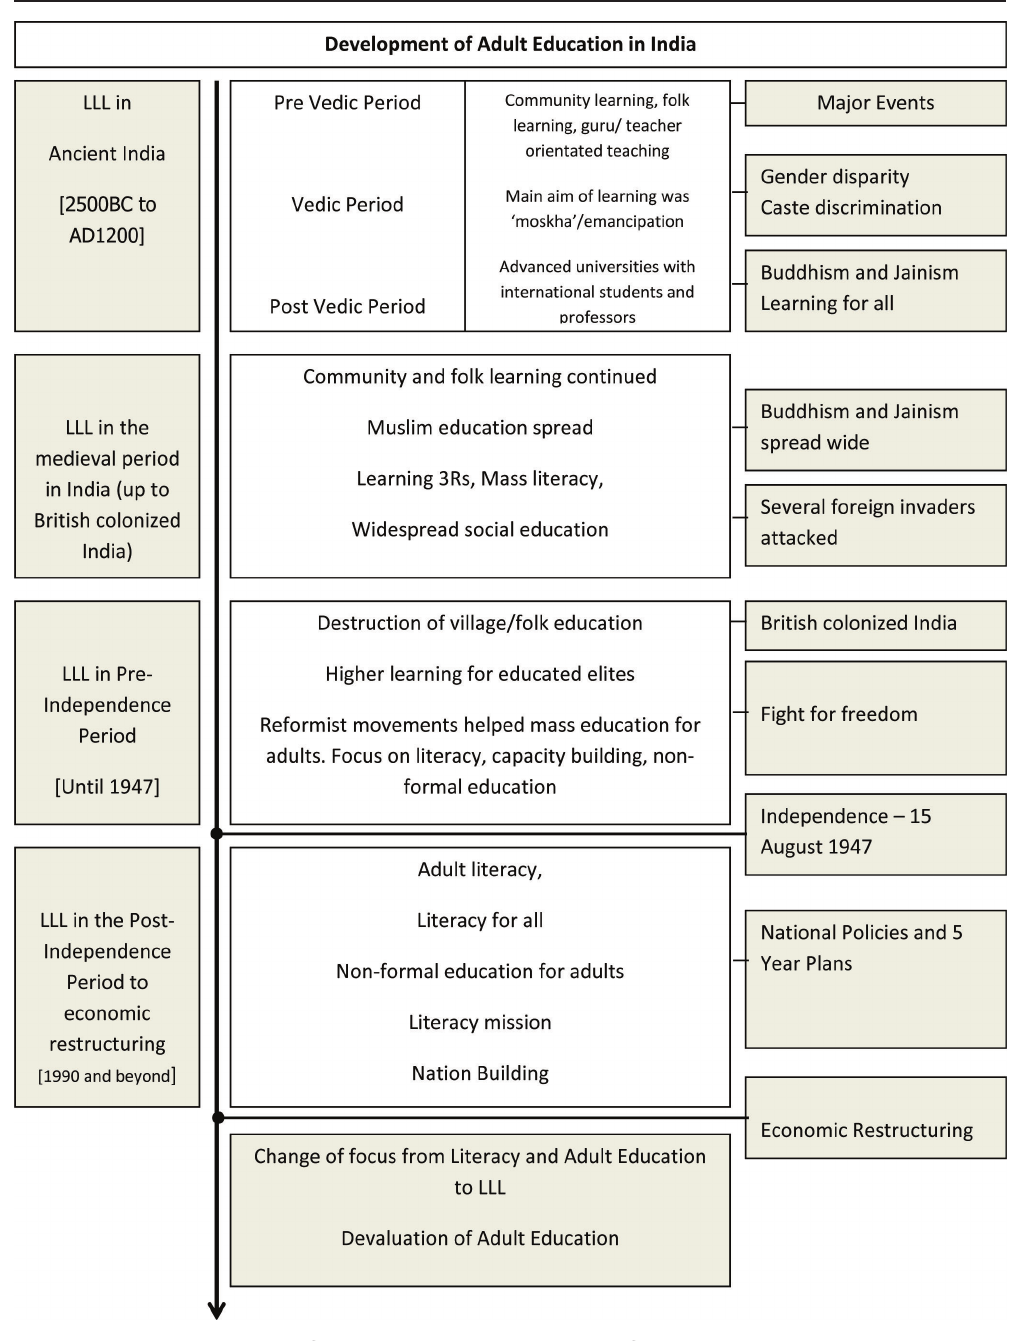
Figure 1: Development of adult education in India (after Shah, 1999; Dutta, 1986) Later, during British rule, the country witnessed a total change in the social and administrative order. As analysed by Singh (1957), the colonizers’ policy in India was to turn the country into a producer of raw materials for British industries, and as a consequence, education as a whole was neglected initially. Later, they started establishing primary schools and AE centres (Chatterjee, 1998, 2002) where the core curriculum included rudiments of reading, writing and deciphering. A number of non- governmental organizations and social reform societies, many of which also worked as catalysts for the freedom movements, played a significant role in promoting AE during the first quarter of the twentieth century. The period 1927–47 may be marked